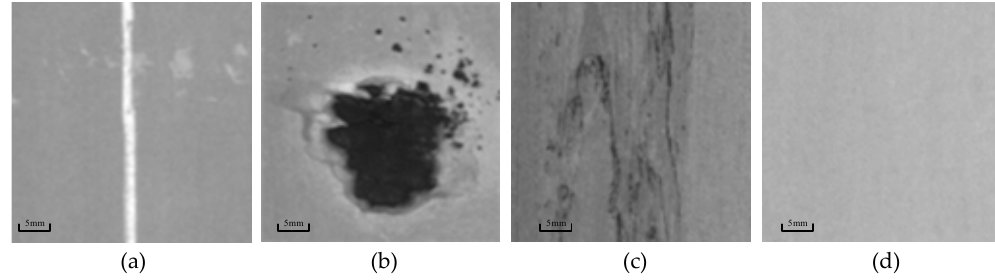
Figure 6. Original defect images: scratches ( a ), slags ( b ), peels ( c ), no defects ( d ).